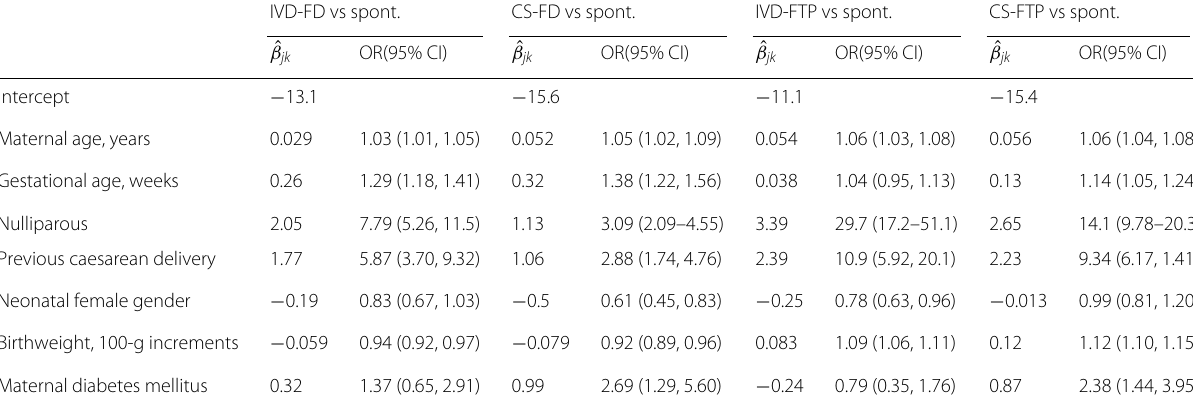
Table 1 Multivariable associations for multinomial antepartum prediction model, predicting the risk of operative delivery IVD-FD vs spont. CS-FD vs spont. IVD-FTP vs spont. CS-FTP vs spont.